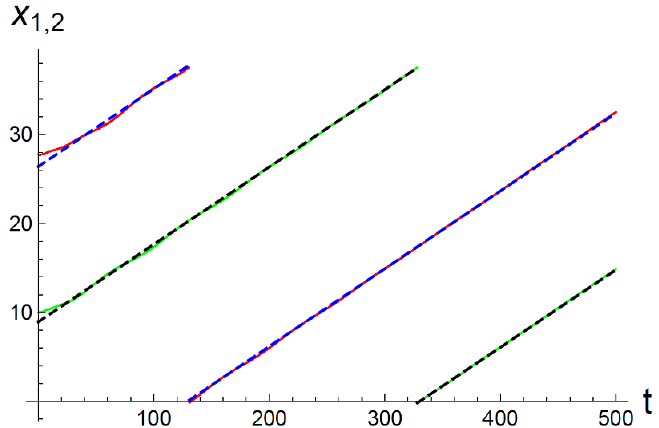
Figure 9 . Evolution of the points x 1 ( t ) (red line), on the domain wall with increasing en- ergy, and x 2 ( t ) (green line), on the domain wall with decreasing energy, satisfying (cid:15) ( t; x 1 ; 2 ( t )) = (max x (cid:15) ( t; x ) + min x (cid:15) ( t; x )) = 2. The blue and black dashed lines represent the linear (cid:12)ts in eq. (5.1), with parameters (5.2) and (5.3), respectively.